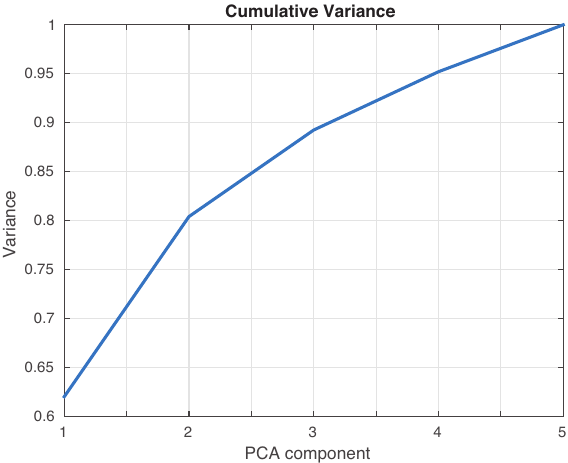
Figure 31. Cumulative contribution rate of variance accounted for the principal components from the data acquired from the composite